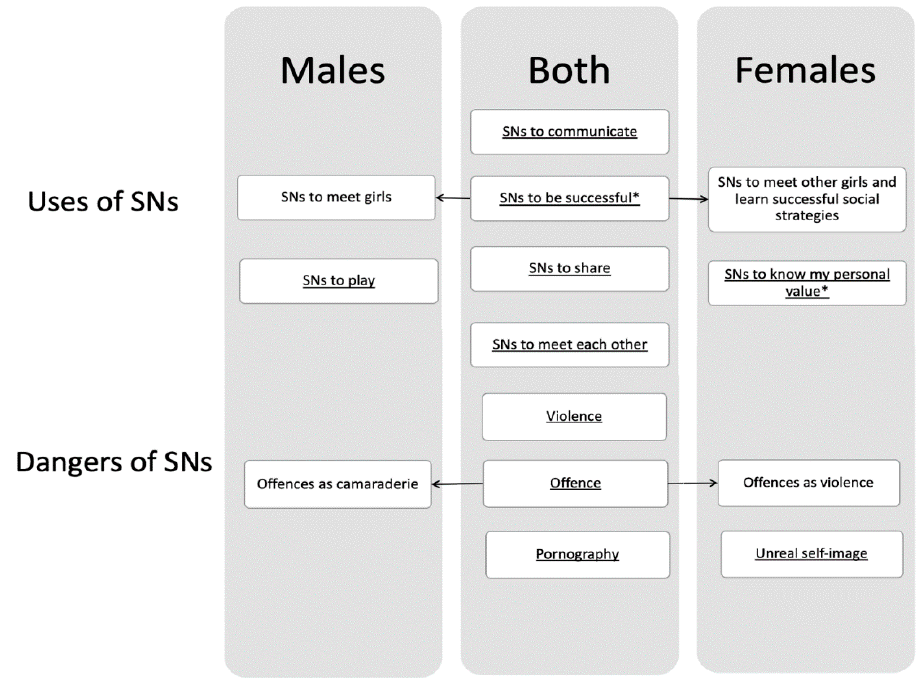
Figure 1. Relations between the first and second-level categories and the gender of the participants.